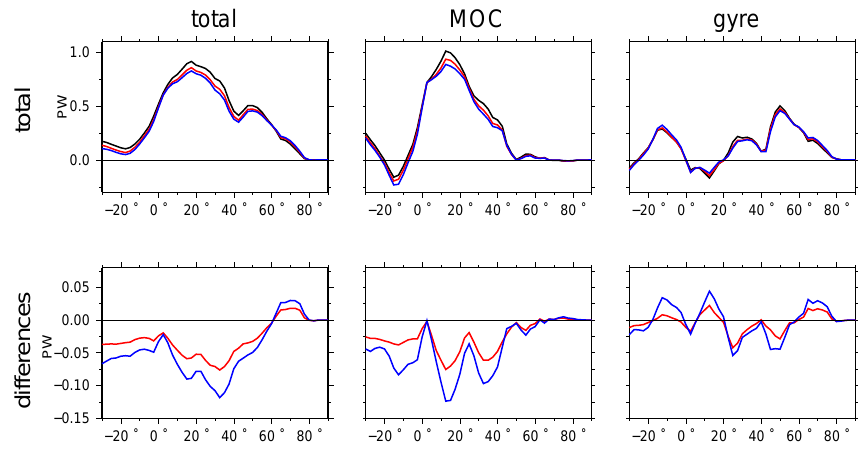
Fig. 7. Upper row: heat transports in PW ( 10 15 W) in the Atlantic basin in pre-industrial (black), Holocene (red), and Eemian (blue) simulations, total and contributions to heat transport from meridional overturning circulation and via gyre transport. Lower row: heat transport differences for Holocene - pre-industrial (red) and Eemian - pre-industrial (blue).